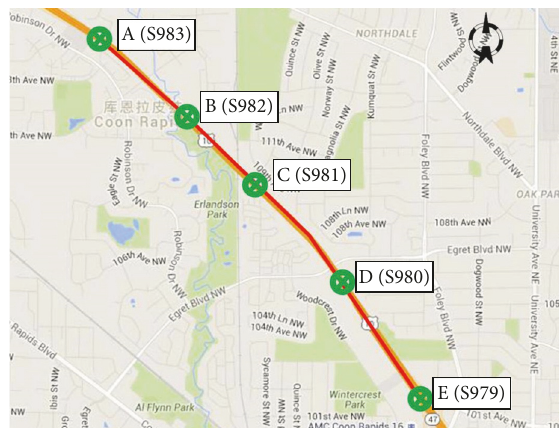
Figure 2: Location of 5 adjacent stations on I-394 segment, from station S979 to station